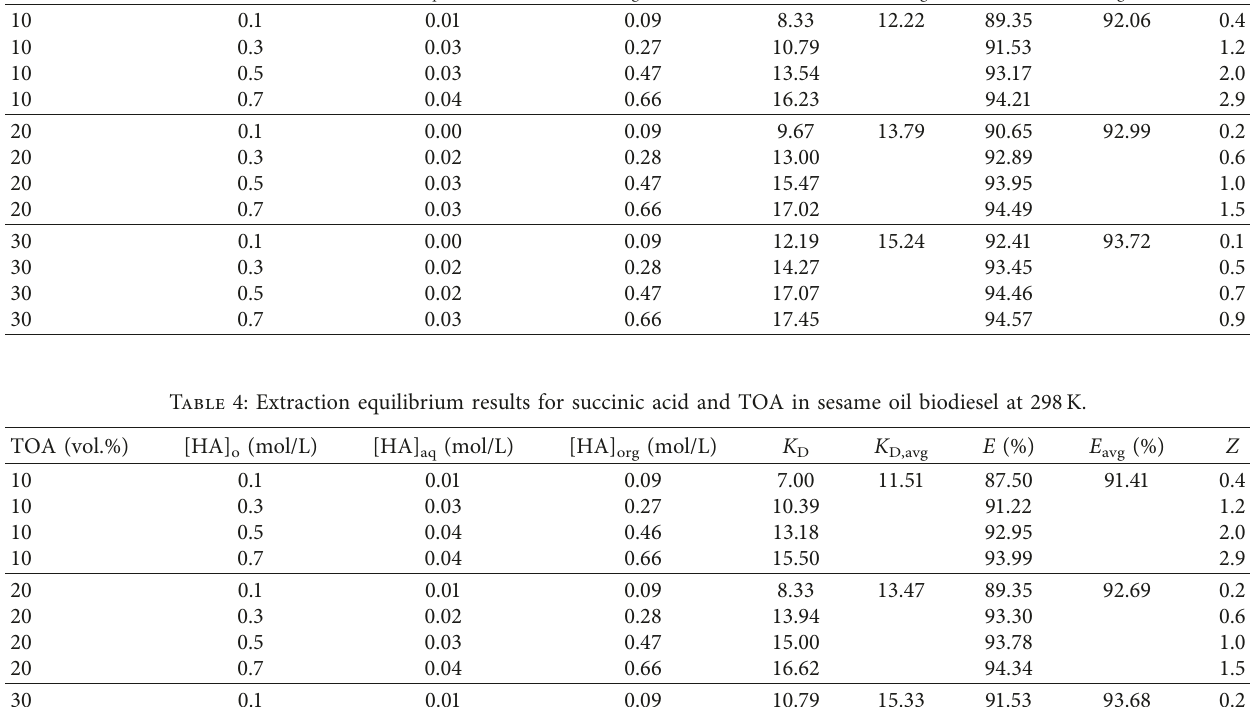
Table 3: Extraction equilibrium results for succinic acid and TOA in rice bran oil biodiesel at 298K. TOA (vol.%)